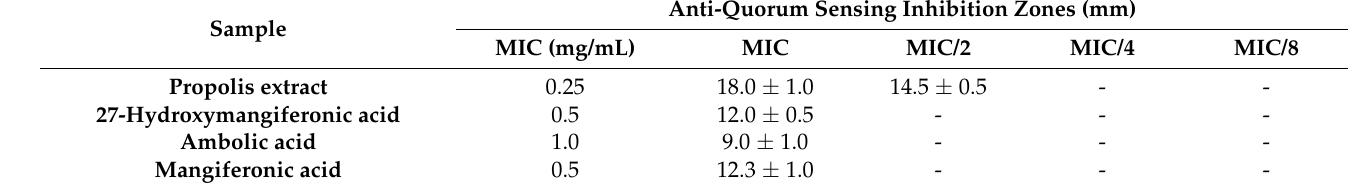
Table 5. Quorum sensing inhibition zones in C. violaceum CV026 of propolis extract and isolated compounds.